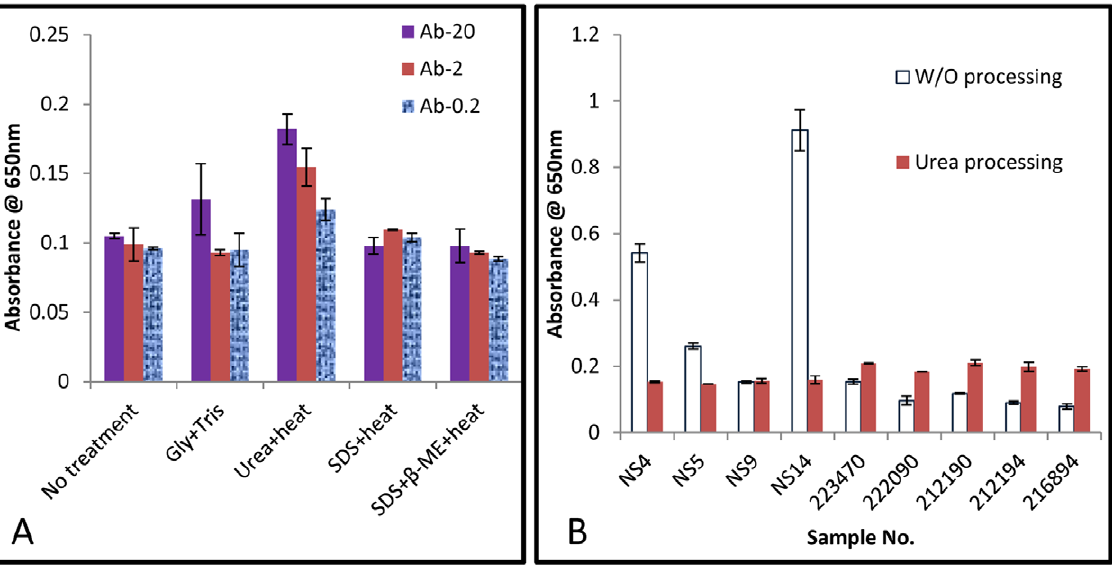
Figure 5. The effect of chemical treatment on the antigen detection level in the simulated and clinical samples. A: The effect of different chemical treatments (as mentioned along x-axis) on antigen detection level (in simulated samples). The three different antibody concentrations are mentioned at the top right hand side. Each condition (under each antibody concentration) was tested in triplicates. B: The antigen level detected with the clinical samples. The clear bar shows the result without (w/o) any pre-treatment while the pre-treated samples are shown via the dark bar. The first four samples were negative and rest were positive clinical samples. Each sample was tested in duplicate. doi:10.1371/journal.pone.0032340.g005 PLoS ONE |